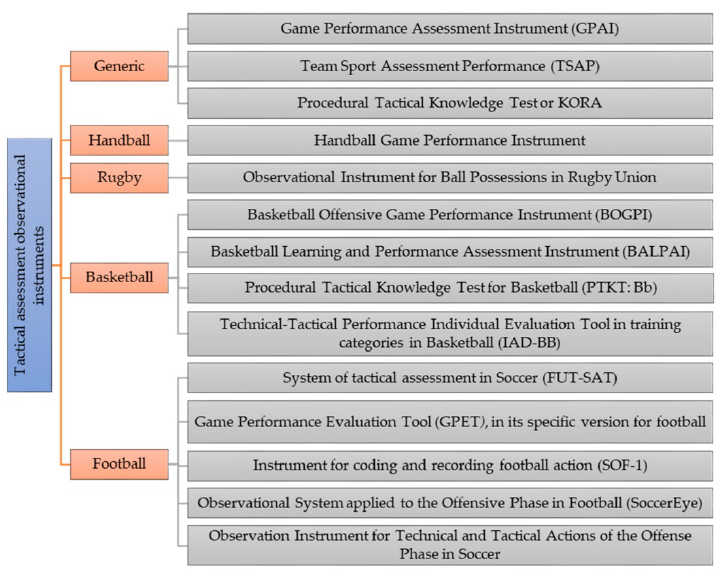
Fig. 1 Basketball tactics scoring and evaluation hierarchy analysis